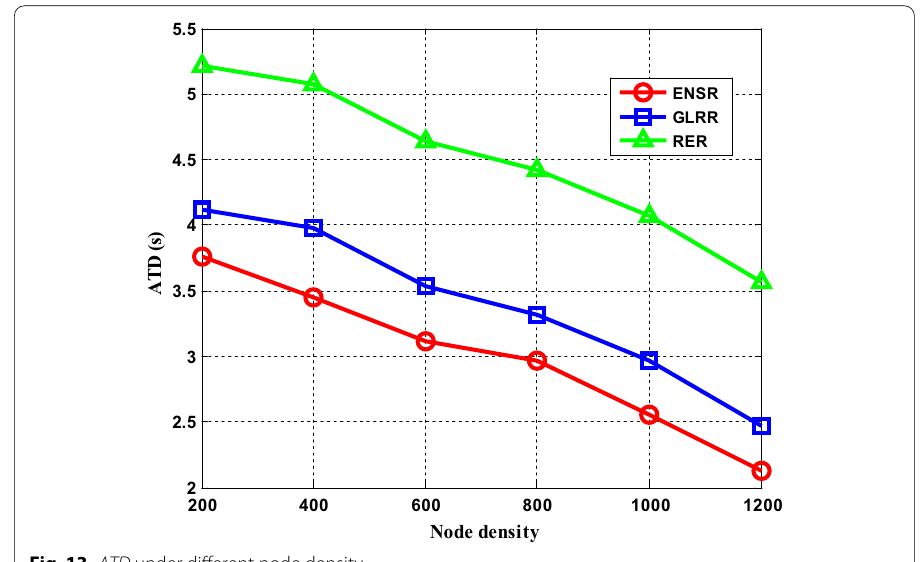
Fig. 13 ATD under different node